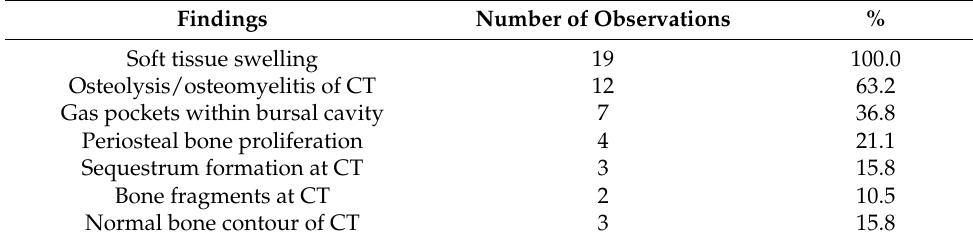
Table 2. Overview of 29 cattle with septic bursitis of the SCB divided into group 1 (septic SCB only) and group 2 (septic SCB with concurrent bone and SDFT involvement), number of eu- thanized cattle, number of treated cattle, number of cattle with postoperative complications and cattle with successful outcomes; SCB—subtendinous calcaneal bursitis; SDFT—superficial digital flexor tendon.